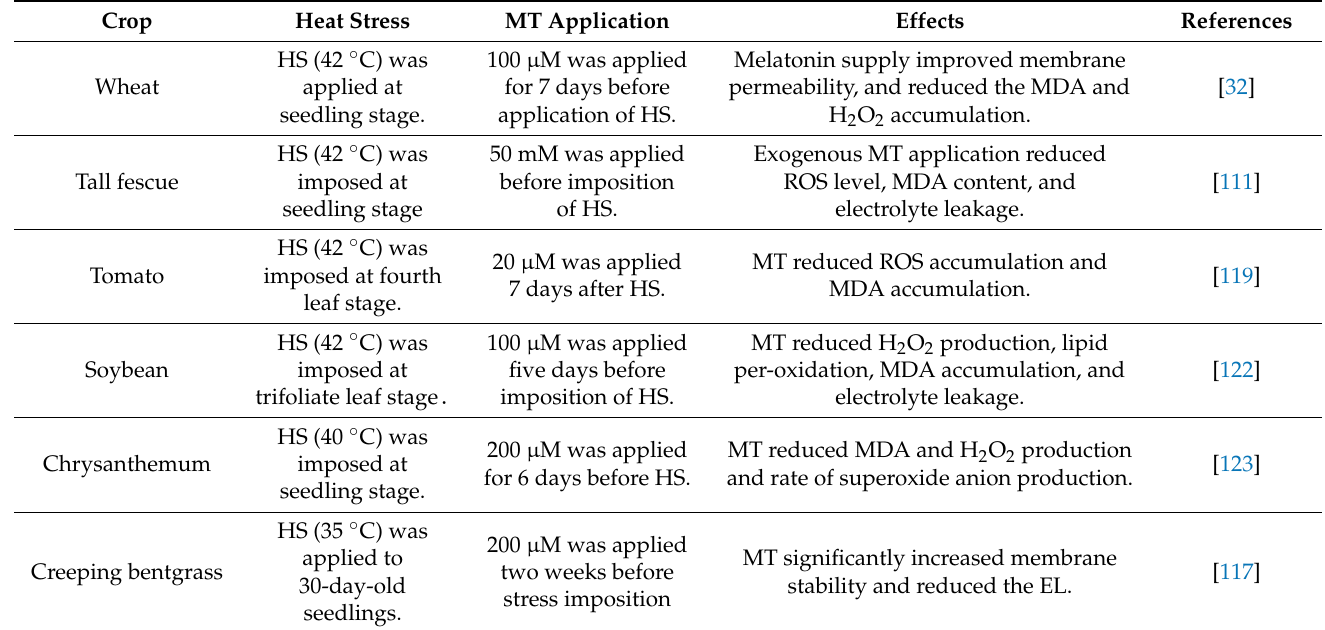
Table 3. Effect of melatonin application on various oxidative stress markers under heat